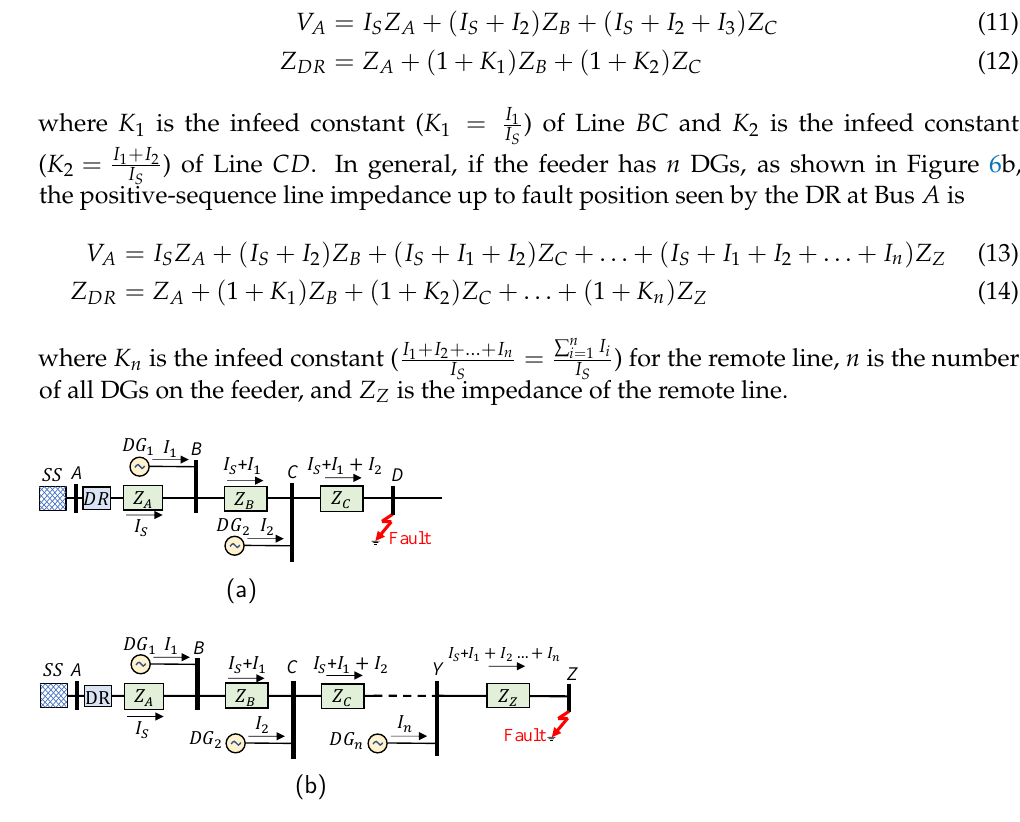
Figure 6. Infeed effect on distance protection: ( a ) radial distribution feeder with three DGs ; ( b ) radial distribution feeder with n DGs